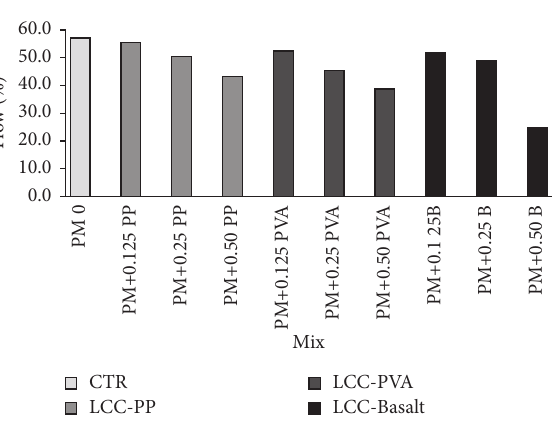
Figure 4: Flow value of